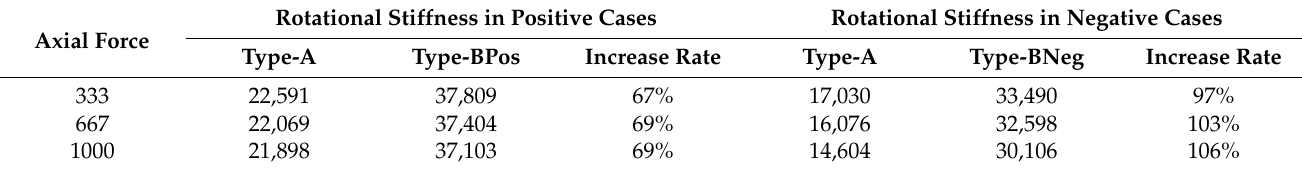
Table 7. Summary of the rotational stiffnesses during the third stage under different axial forces (stiffness unit: kN · m/m/rad, axial force unit: kN/m). Axial